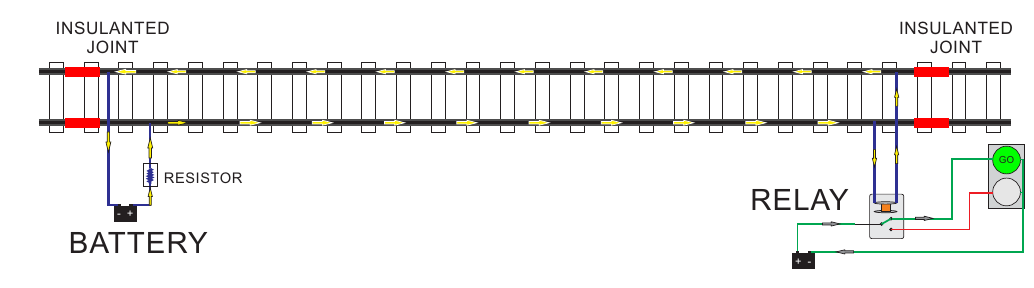
Figure 1. Example of a DC track circuit